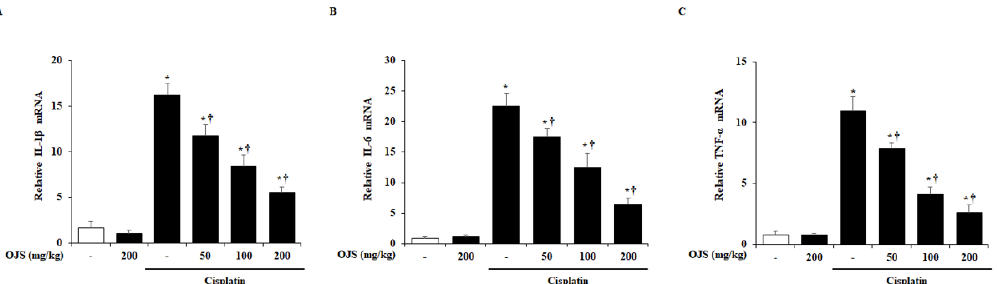
Figure 4. OJS treatment reduces renal cytokine production in cisplatin-induced AKI. RT PCR anal- yses of ( A ) IL- 1β, ( B ) IL-6, and ( C ) TNF- α. Data are represented as mean ± S.E.M . ( n = 9; * indicates p < 0.05 vs. saline-treated control group, † indicates p < 0.05 vs. cisplatin treatment alone).